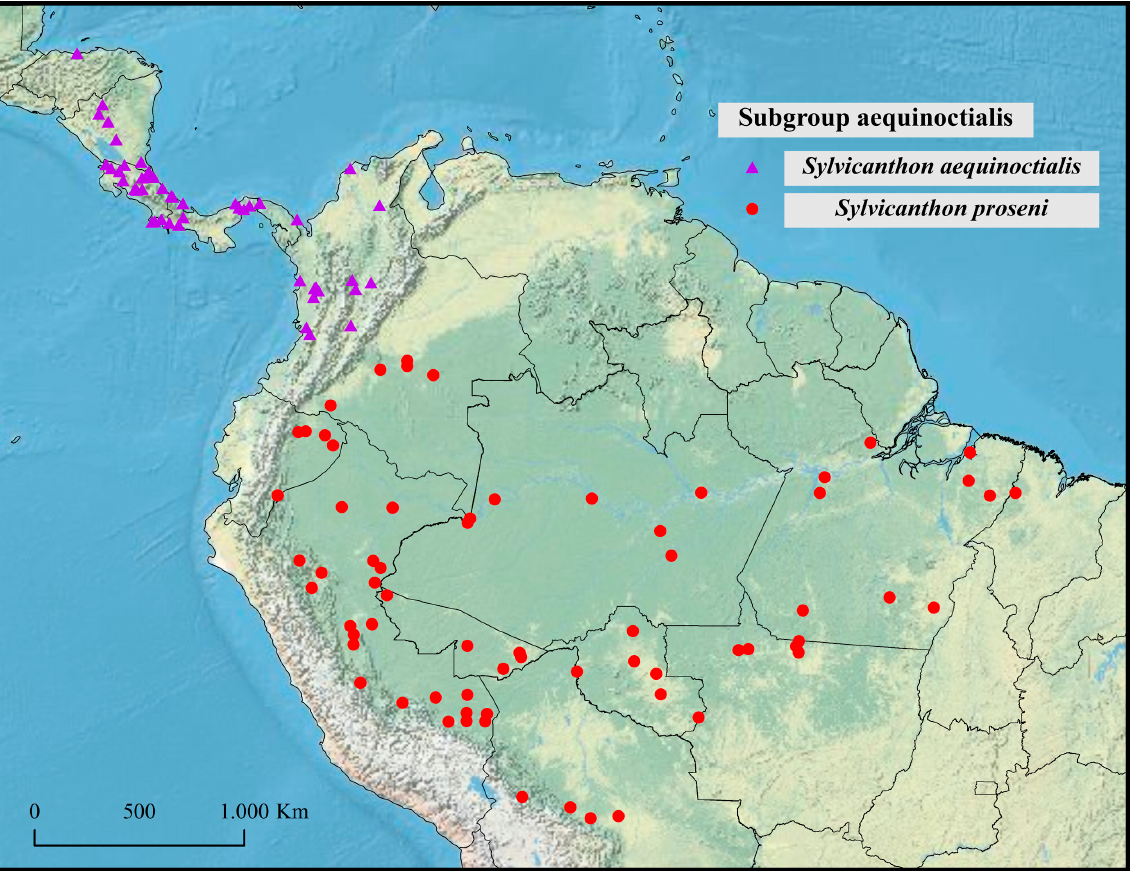
Fig. 30. Distribution of the two species of the